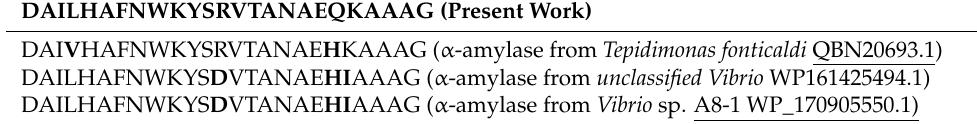
Table 2. N-terminal sequence analysis of